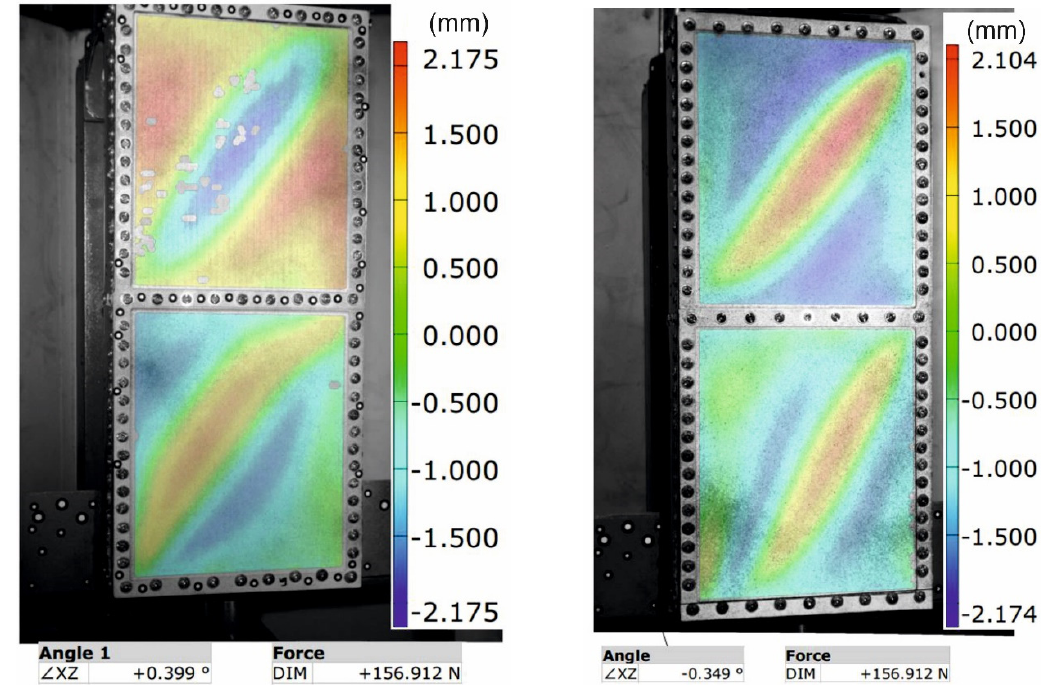
Figure 17. Results of measurements of the displacement component in the normal direction to the wall plane, determined with an optical scanner.